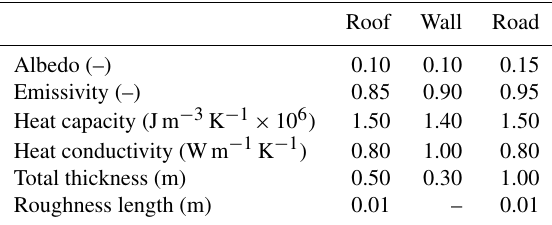
Table 2. Material properties used in the urban canopy